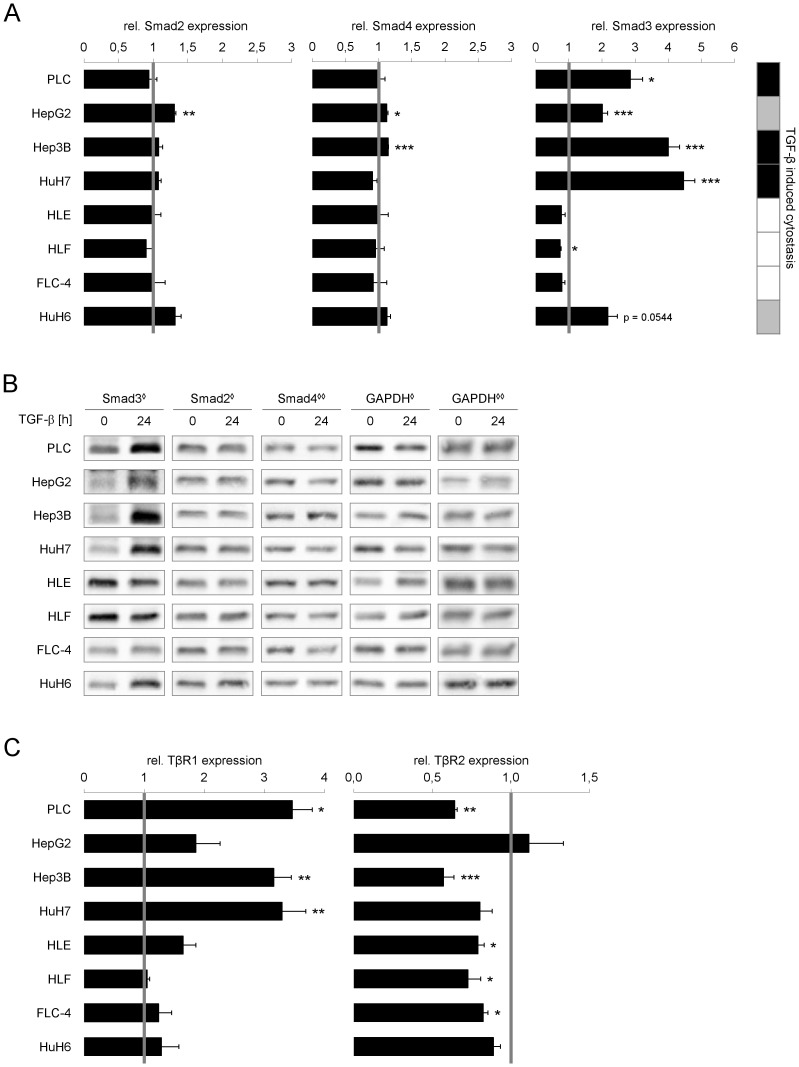
Induction of Smad3 and TβRI expression correlates with cytostatic responsiveness upon TGF-β treatment.Cells were cultured with or without 5 ng/ml TGF-β for 24 h. Changes in Smad2, Smad3 and Smad4 levels after TGF-β treatment were evaluated by (A) Real Time PCR and (B) Western Blot analysis using 18S rRNA or GAPDH as reference genes. ◊ and ◊ ◊ indicate which GAPDH belongs to Smad2 and Smad3 or Smad4, respectively. (C) TGF-β dependent expression levels of TGF-β Receptor I (TβRI) and II (TβRII) were detected and correlated against untreated samples using real time PCR with 18S rRNA as reference gene. Untreated samples are shown as grey lines, while filled bars display TGF-β treated samples. Significant differences are indicated as * p < 0.05, ** p < 0.01 and *** p < 0.001 (Student’s t test).